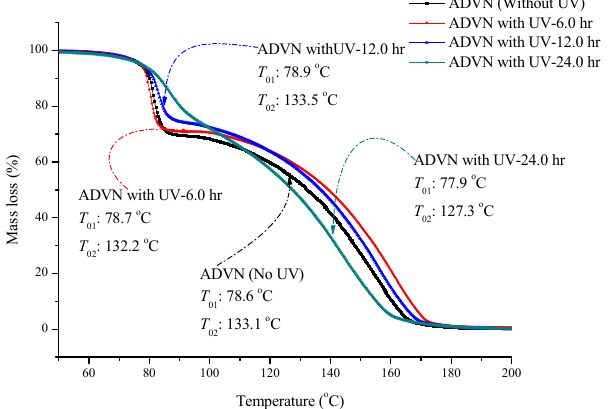
Figure 3. TG thermal curve of ADVN and ADVN with different exposure durations of UV/6, 12 and 24 h.